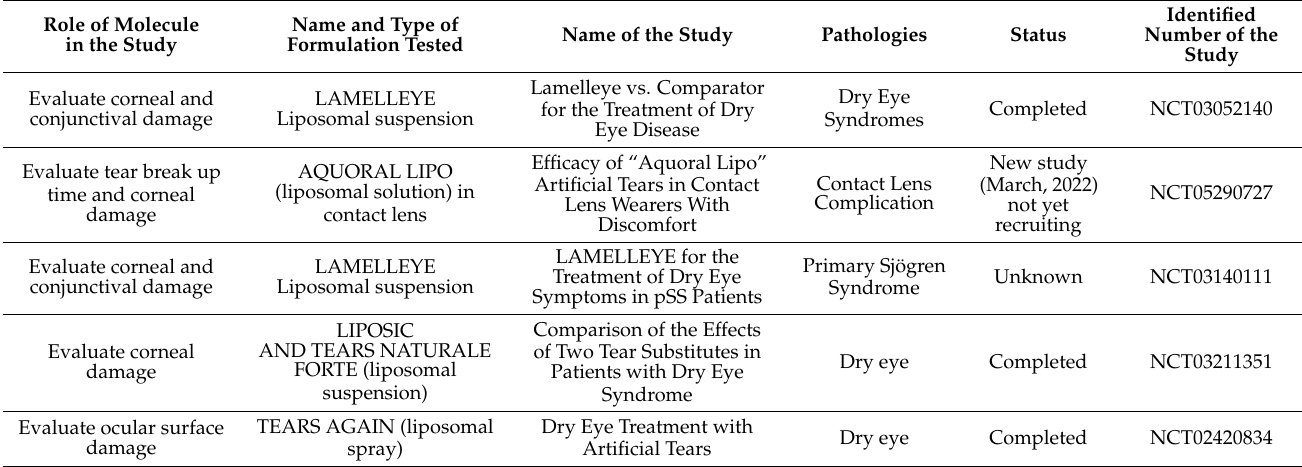
Table 3. Use of Fluorescein dye in clinical trials of drug delivery systems for eye